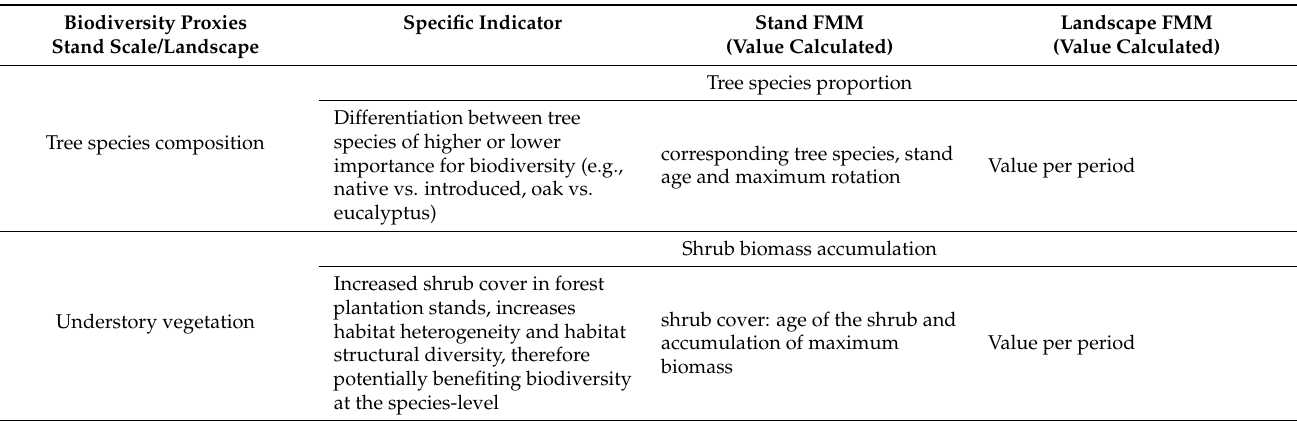
Table 2. Biodiversity proxies’ indicators used to categorize all FMMs at stand and landscape scale. Biodiversity Proxies Specific Indicator Stand FMM Landscape FMM Stand Scale/Landscape (Value Calculated) (Value Calculated) Tree species proportion Differentiation between tree species of higher or lower Tree species composition corresponding tree species, stand importance for biodiversity (e.g., Value per period age and maximum rotation native vs. introduced, oak vs. eucalyptus) Shrub biomass accumulation Increased shrub cover in forest plantation stands, increases shrub cover: age of the shrub and Understory vegetation habitat heterogeneity and habitat accumulation of maximum Value per period structural diversity, therefore biomass potentially benefiting biodiversity at the species-level